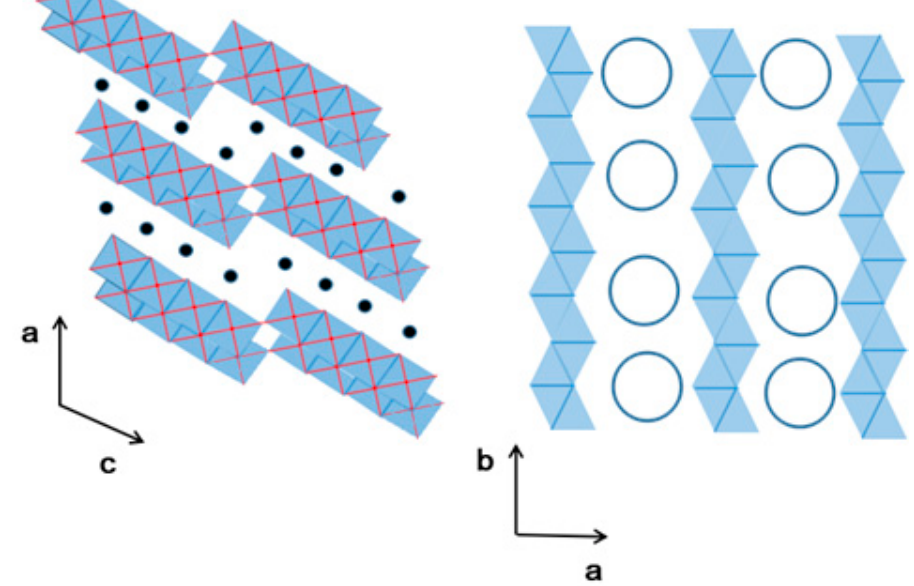
Figure 4. The structure modes of K 2 Ti 6 O 13 viewing along the {0 1 0} direction.